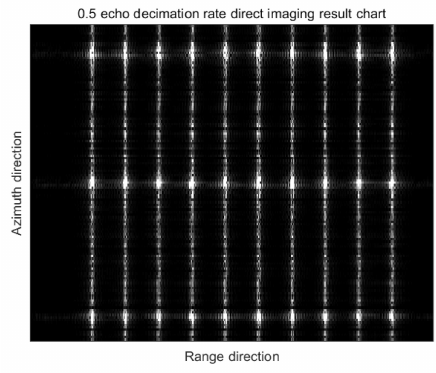
Figure 7. Direct imaging result of the 0.5 echo extraction